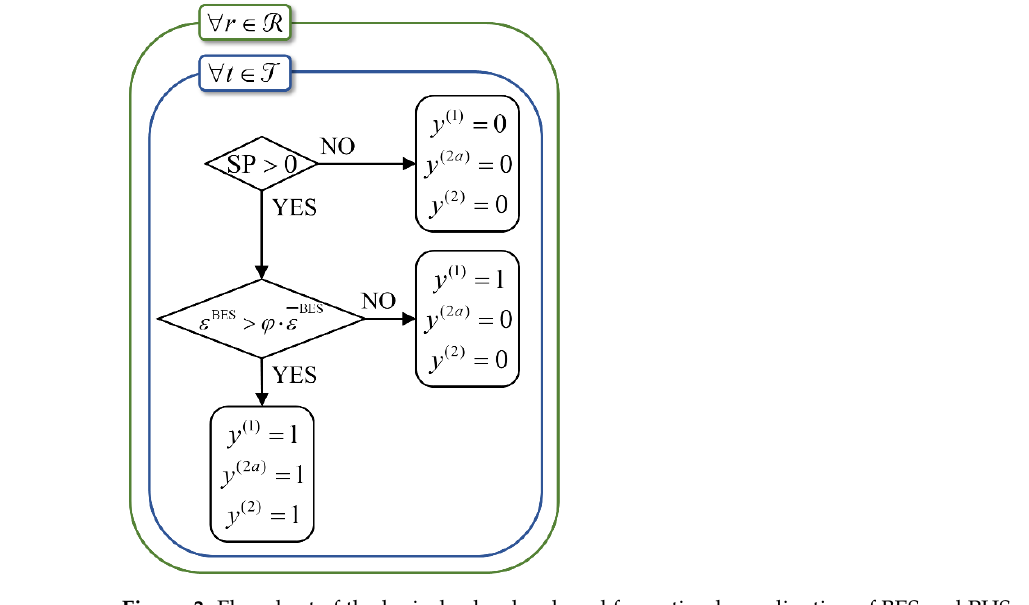
Figure 3. Flowchart of the logical rules developed for optimal coordination of BES and PHS and their relationship with the introduced binary variables.